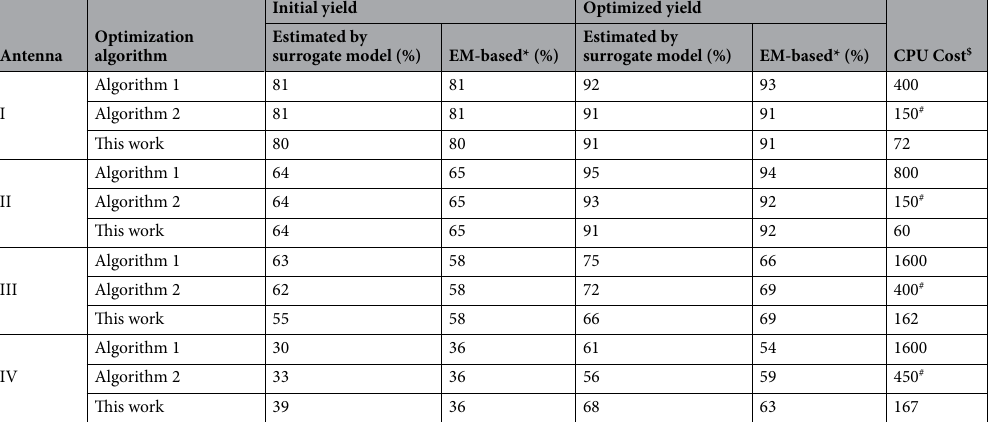
Table 3. Yield optimization results for Antennas I through IV. $ Optimization cost in number of EM analyses of the antenna structure. # The cost calculated as the number of algorithm iterations multiplied by the number of training samples used to set up surrogate for each iteration (50 for Antennas I and II, and 100 for Antennas III and IV). & The cost includes sensitivity estimation ( n EM analyses, cf. (7)), and acquisition of training data for surrogate model construction. *Estimation based on Monte Carlo simulation using 500 random